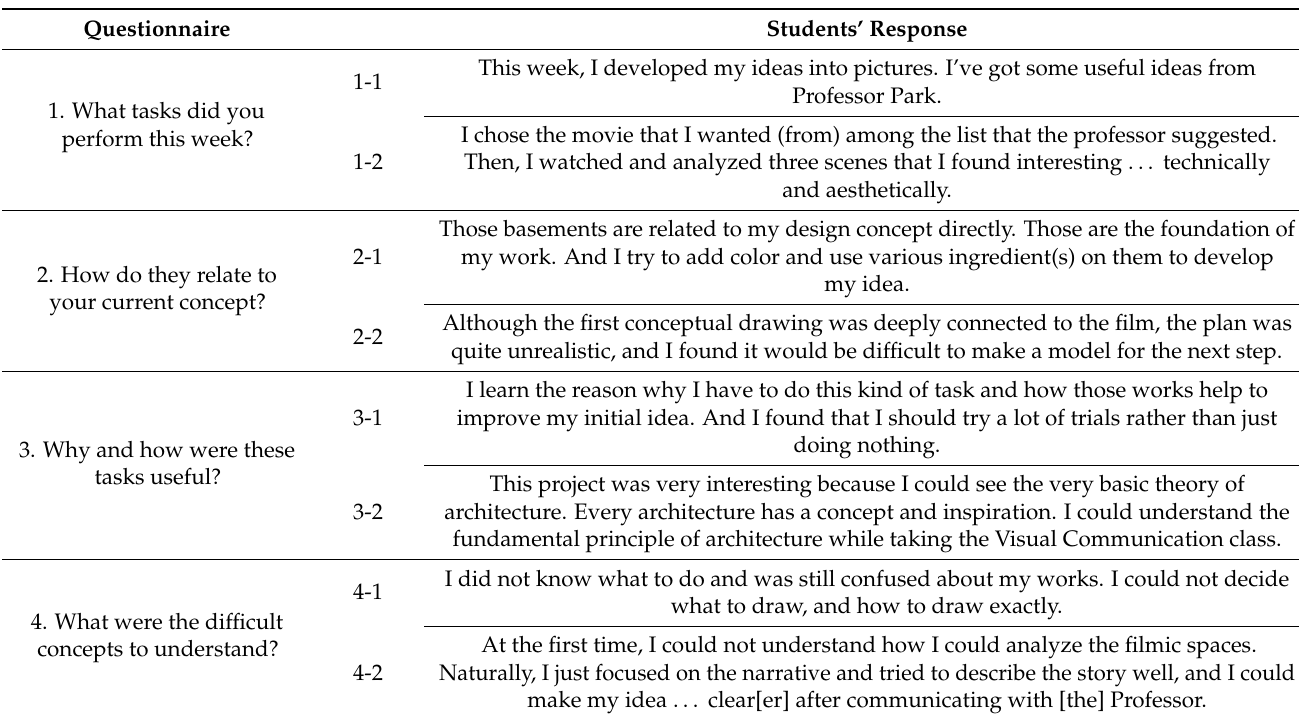
Table 4. Self-evaluation questions: an example of the questionnaire and the student responses.